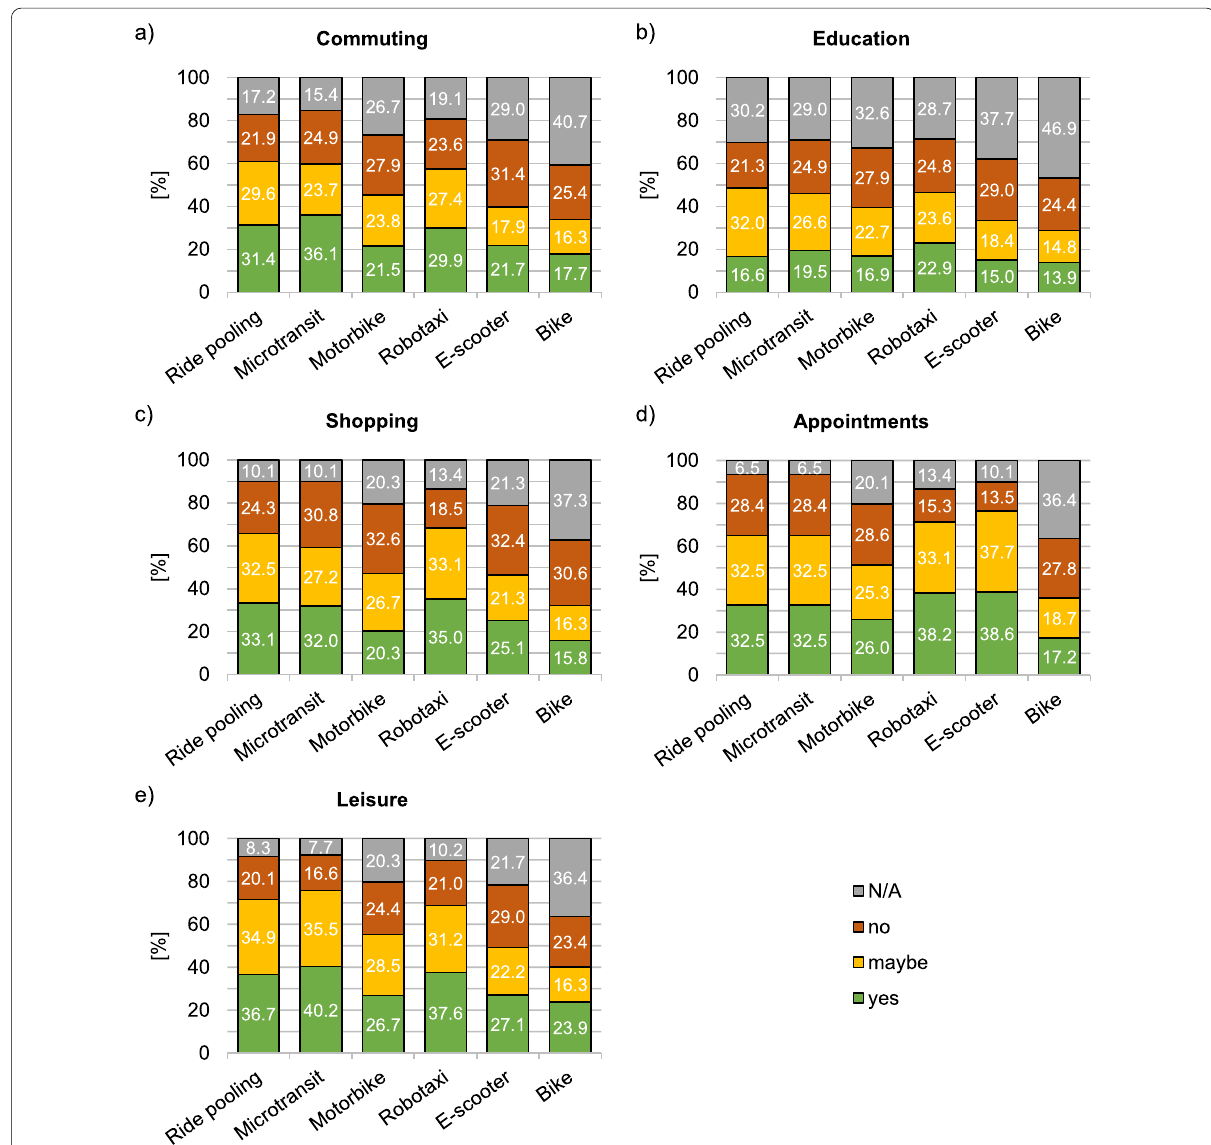
Fig. 4 Intention to use the shared mobility services for the different trip purposes a commuting, b education, c shopping, d appointments, and e leisure across disabilities (N/A: not